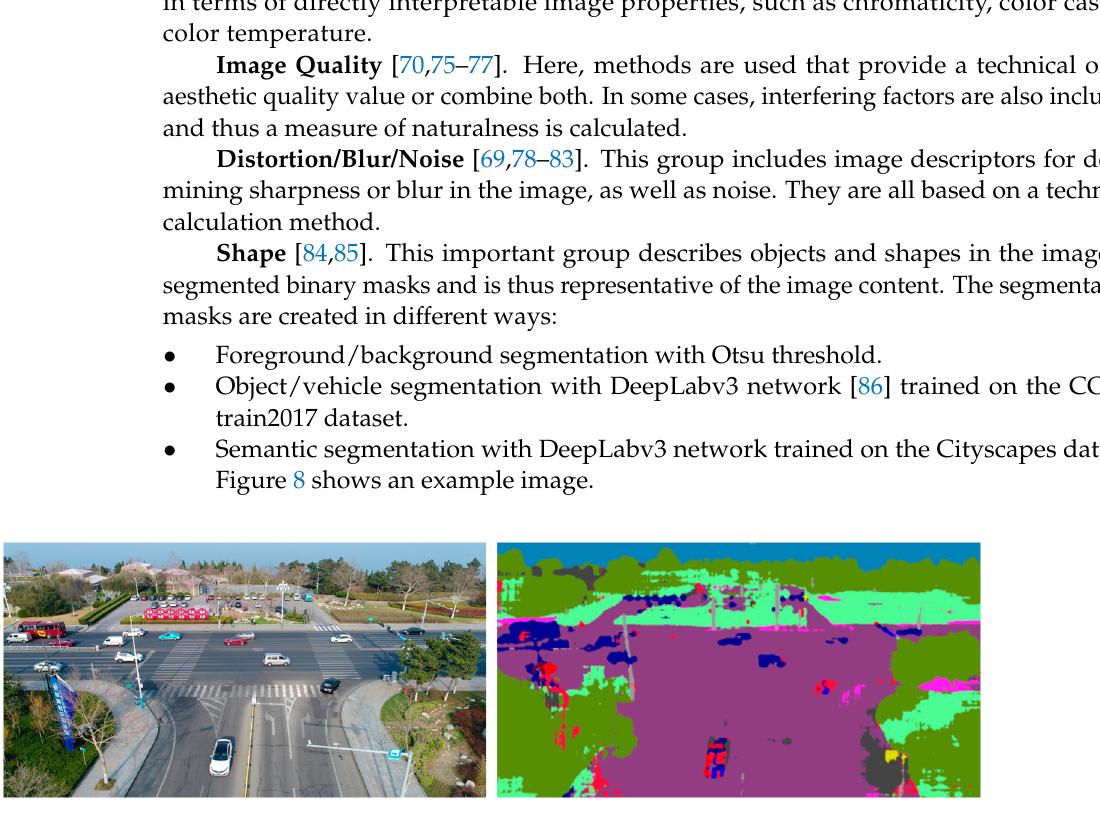
Figure 8. Visualization of the DeepLabv3 output image for visual veri fi cation of the segmentation results.